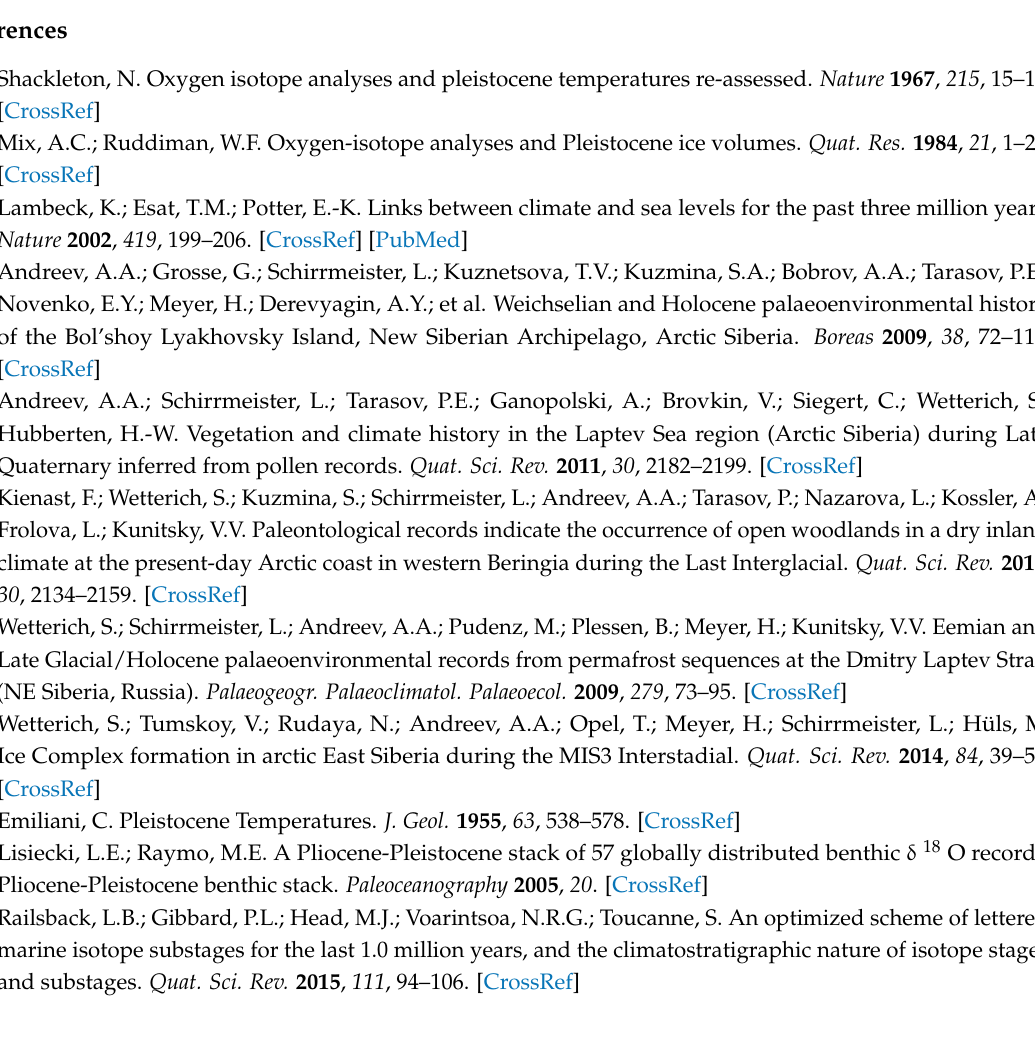
Table S1: Terrestrial vascular plant sedaDNA sequence counts, Table S2: Extraction negative control EH312, Table S3: Extraction negative control EH322, Table S4: Extraction negative control EH342, Table S5: Terrestrial vascular plant pollen